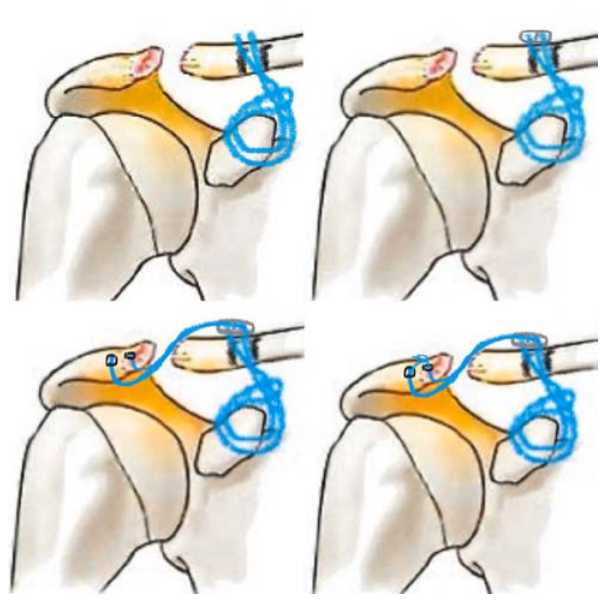
Figure 2. Surgical procedure outlined in concise drawings.